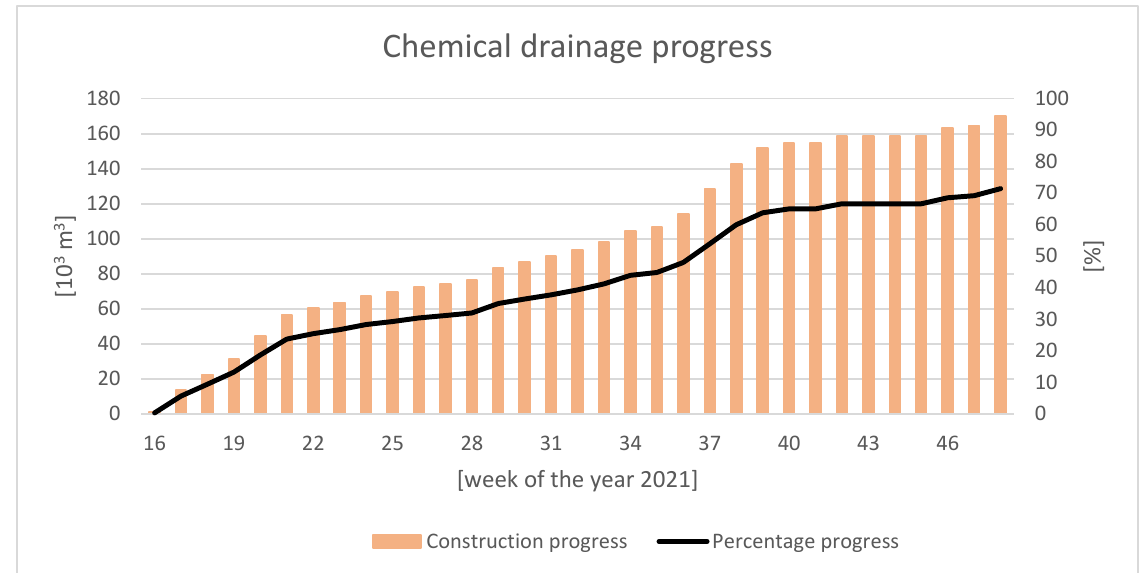
Figure 7. Construction and percentage progress of the stabilisation of Category IV soil (internal analysis based on reports of the project contractor).